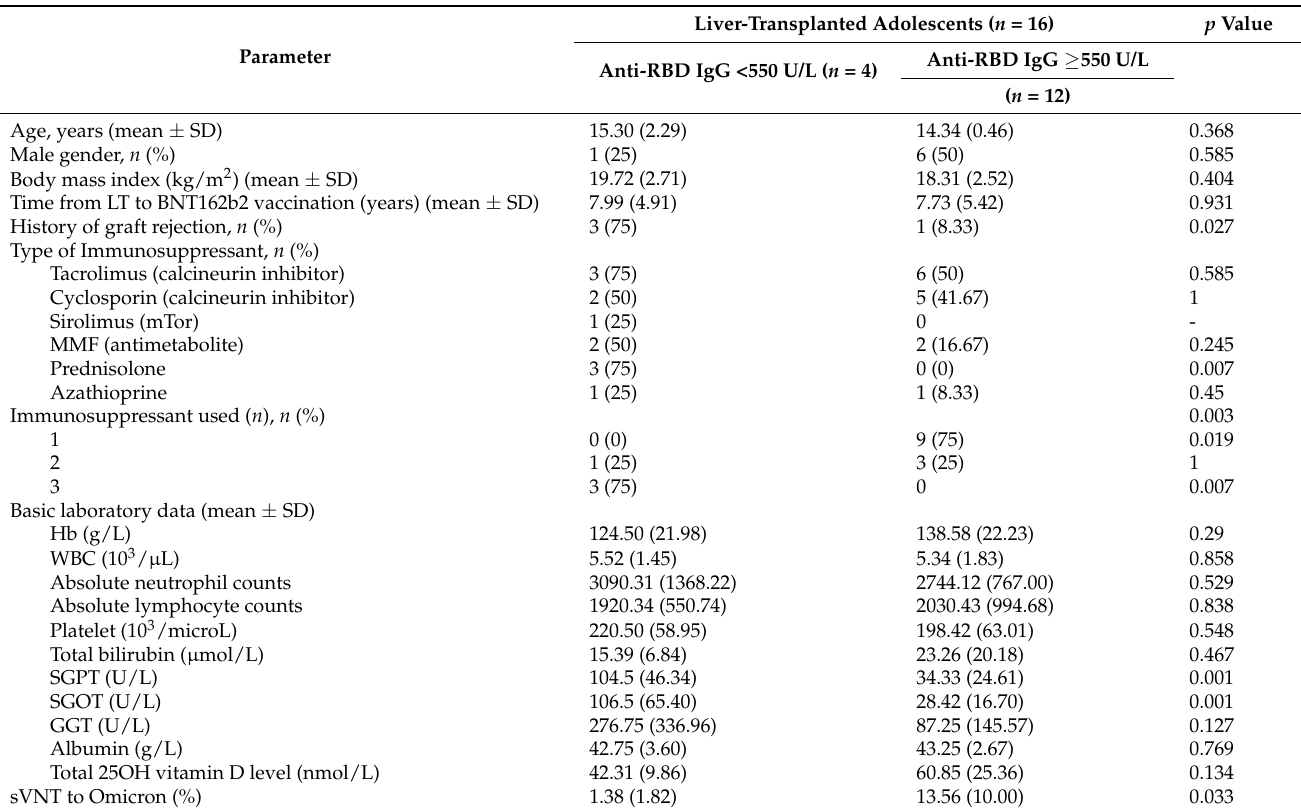
Table 2. Participant characteristics of liver-transplanted adolescents with low and high anti-RBD immunoglobulin levels after completion of the BNT162b2 vaccination.